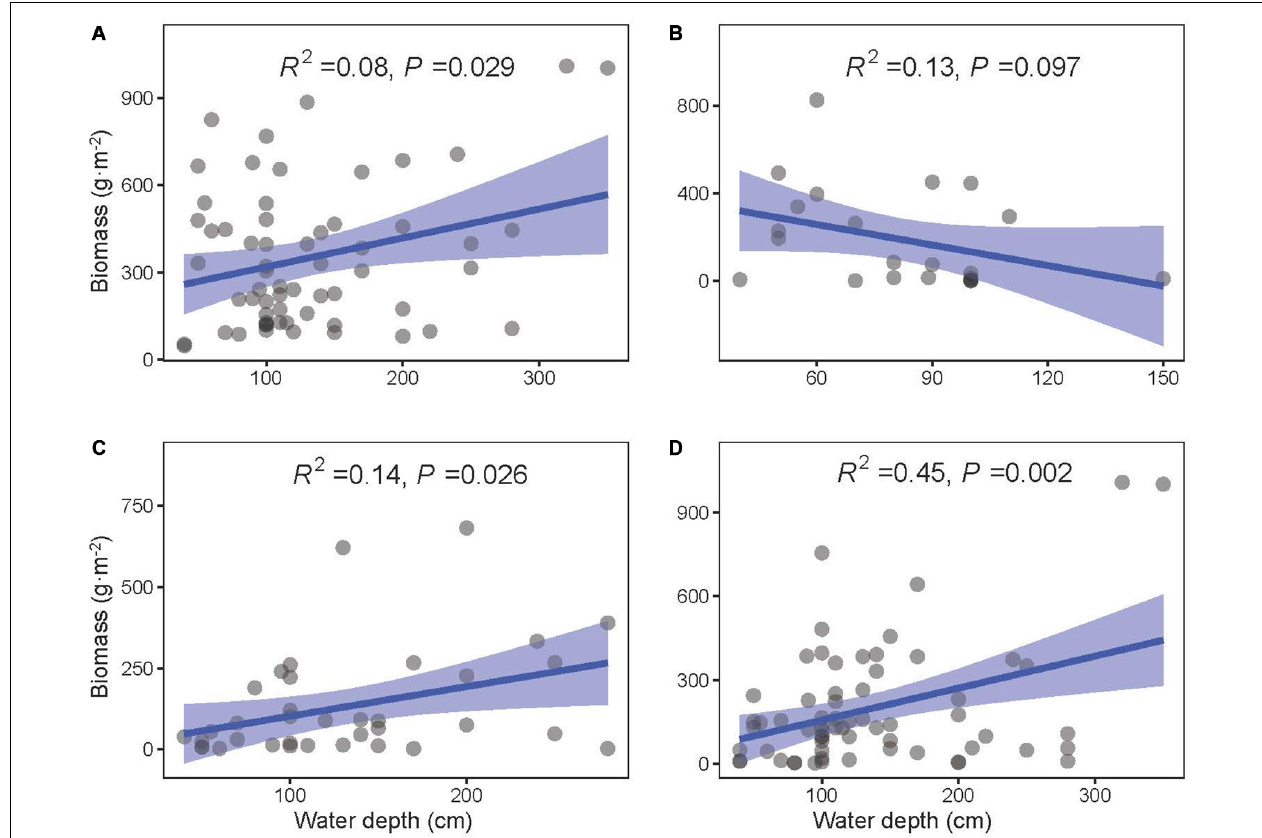
FIGURE 5 | The least-squares linear regressions between water depth and biomass of (A) total, (B) emergent, (C) floating-leaved, and (D) submerged plants. The regression coefficients squared and P -values are given for the regression. The blue area shows the approximate 95% confidence intervals on the fitted function ( n =